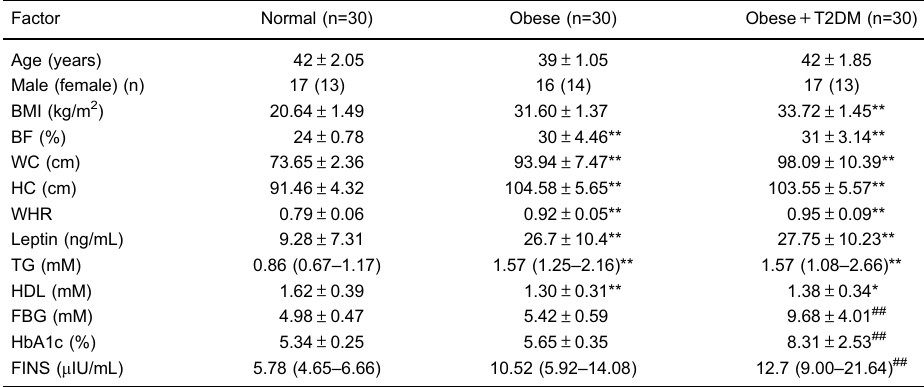
Table 1. Baseline characteristics of the study